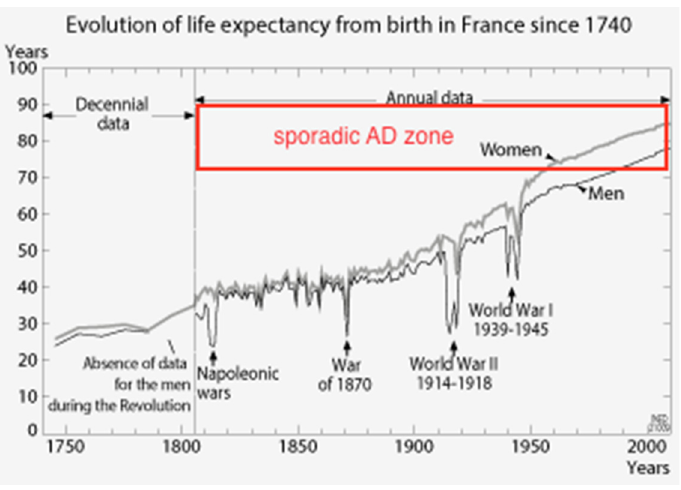
Figure 1. The risk of sporadic AD increases when life expectancy increases.